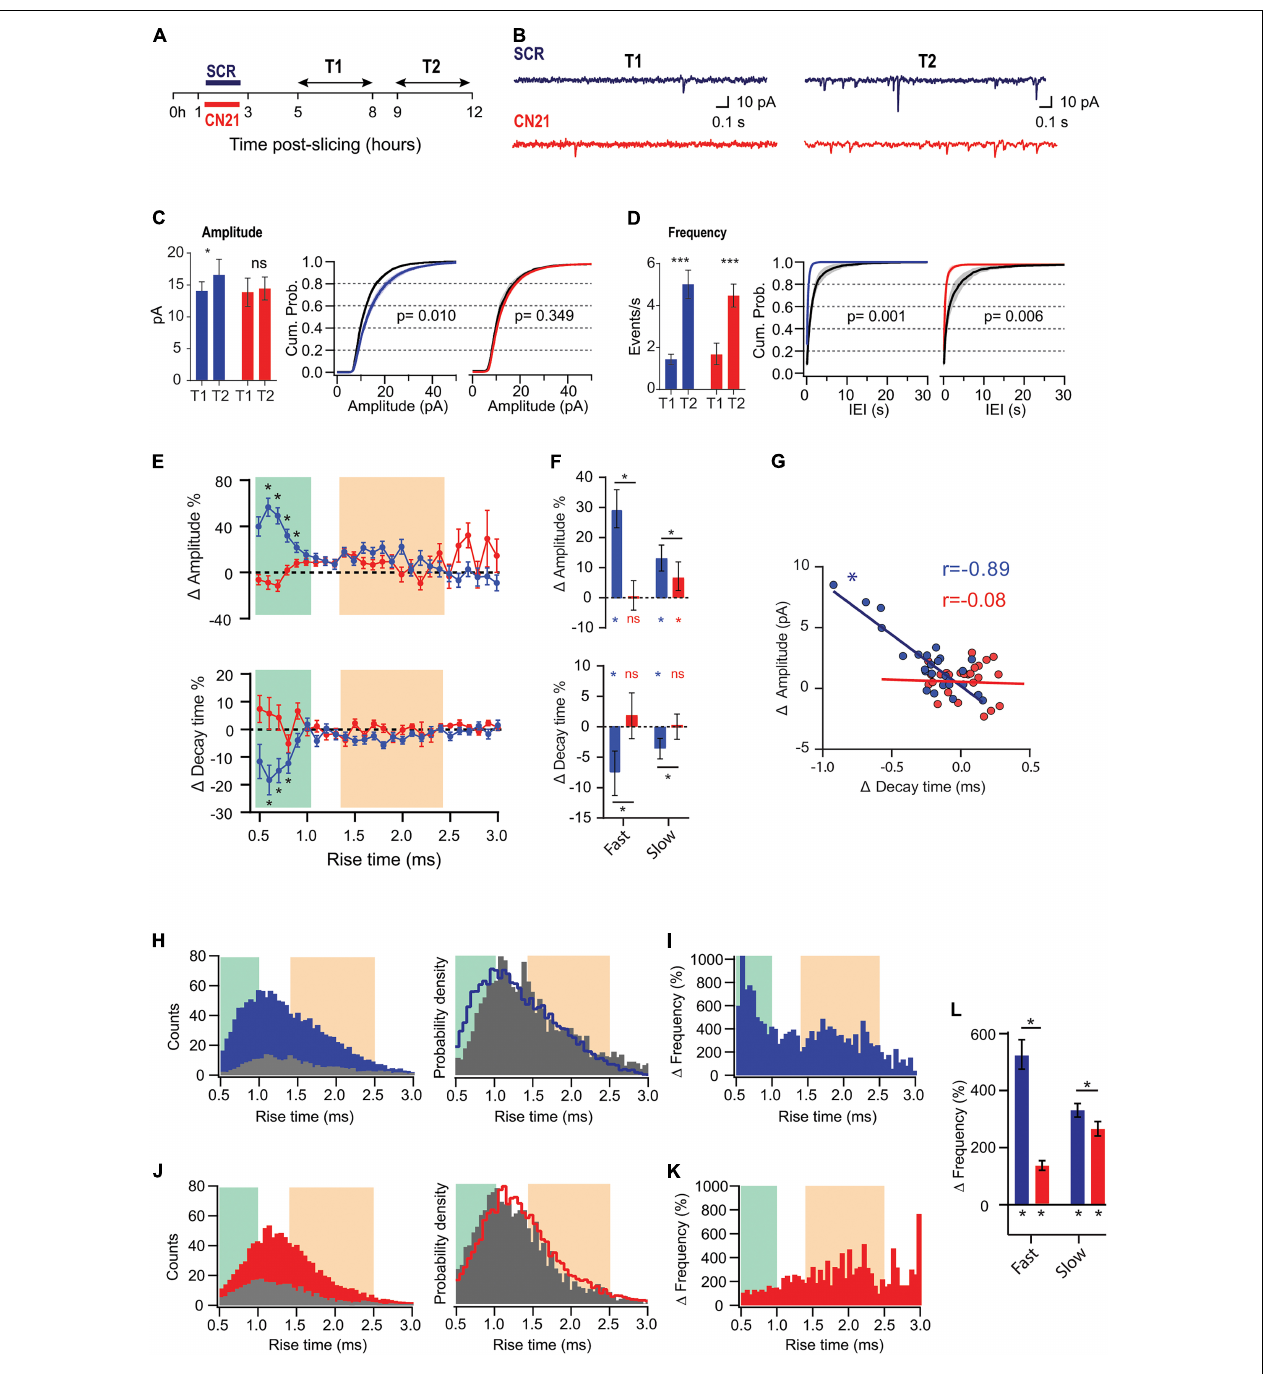
FIGURE 3 | CaMKII is involved in different adaptations in acute slices. (A) Experimental design. Slices were preincubated for 2 h with CN21 or SCR peptide and drugs were washed out for 2 h (T1 and T2 are the same as for Figures 1 , 2 ). (B) Representative current traces recorded at T1 and T2 in each condition (C) Mean mEPSCs amplitudes at T1 and T2 (left) and overlaid cumulative probability curves for CN21 (center) and SCR (right), including all mEPSCs recorded during each period. Black curves: distributions at T1. Two-way ANOVA with Bonferroni correction for bar plot, random permutations for cumulative probability plots. (D) Same as panel (C) for mEPSCs frequency and interevent interval (IEI). (E) Percent changes in amplitude and decay time for τ r -binned data. Bootstrap with weighted P -values. (F) Average amplitude and decay time percent changes for slow and fast-rising groups. Bootstrap with Bonferroni correction. (G) Amplitude vs. decay time raw changes for CN21 or SCR peptide. Each point corresponds to the average change for τ r bin. Pearson correlation. (H) Frequency histograms (left) for all events recorded at T1 or T2 and probability density curve (right), in SCR condition. (I) τ r -binned frequency percent increase. (J,K) Same as (H,I) , for CN21. (L) Average frequency increase for fast and slow groups, after SCR or CN21. Bootstrap with Bonferroni correction. ∗ p < 0.05. N = 39 neurons (SCR-T1: 11, SCR-T2: 8, CN21-T1: 8, CN21-T2: 12), from 5 rats (1–4 slices per rat).